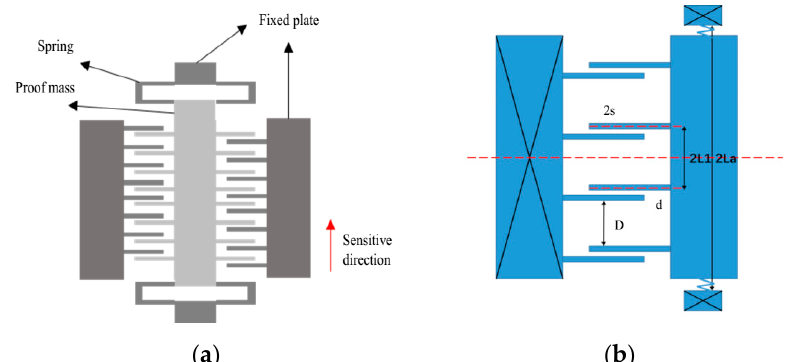
Figure 1. An asymmetric structure model: ( a ) overall structure diagram; ( b ) diagram of the asymmetric comb ( d is the narrow gap, D is the wide gap, 2 s is the width of the comb, L a is the distance from the anchors of the proof mass to the midline, 2 L 1 is the distance of two moving electrodes).